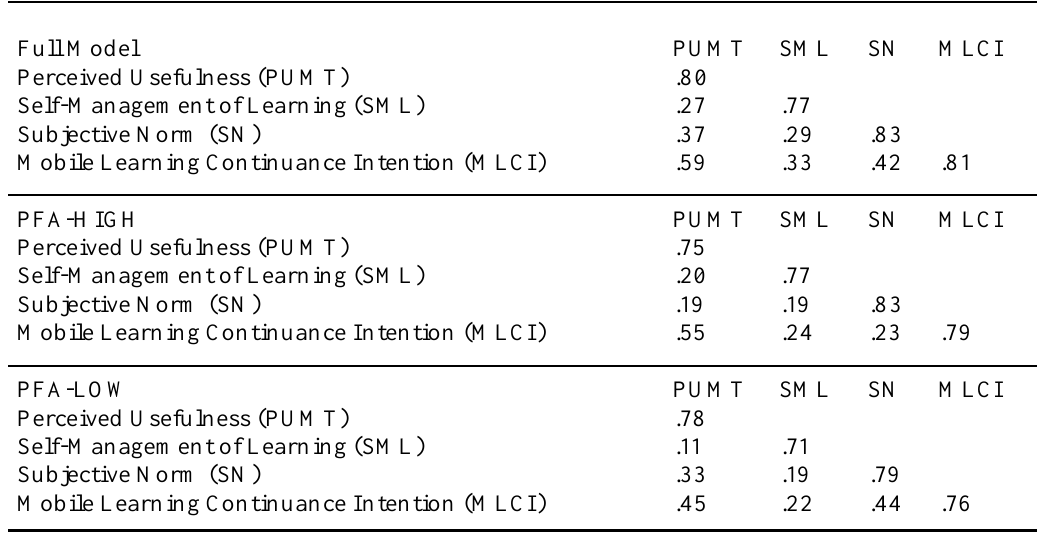
The Correlations of Each Latent Variable among Different Models